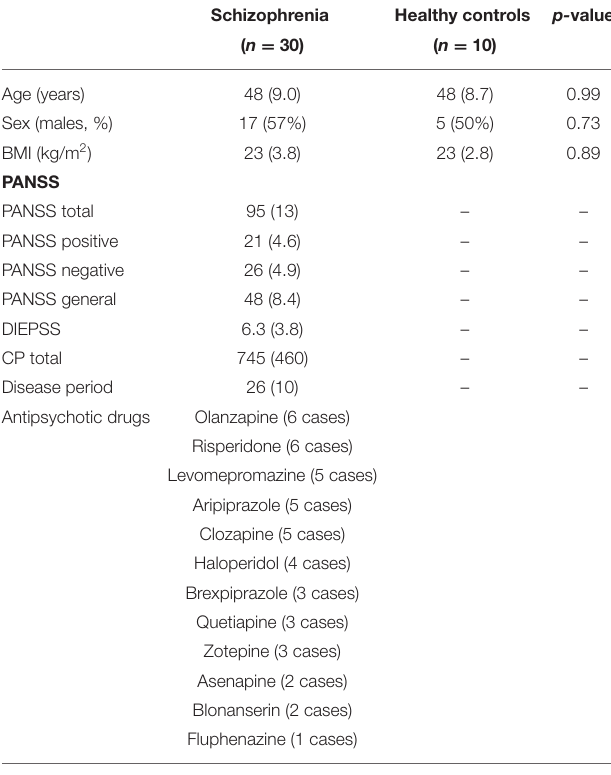
TABLE 1 | Clinical and demographic